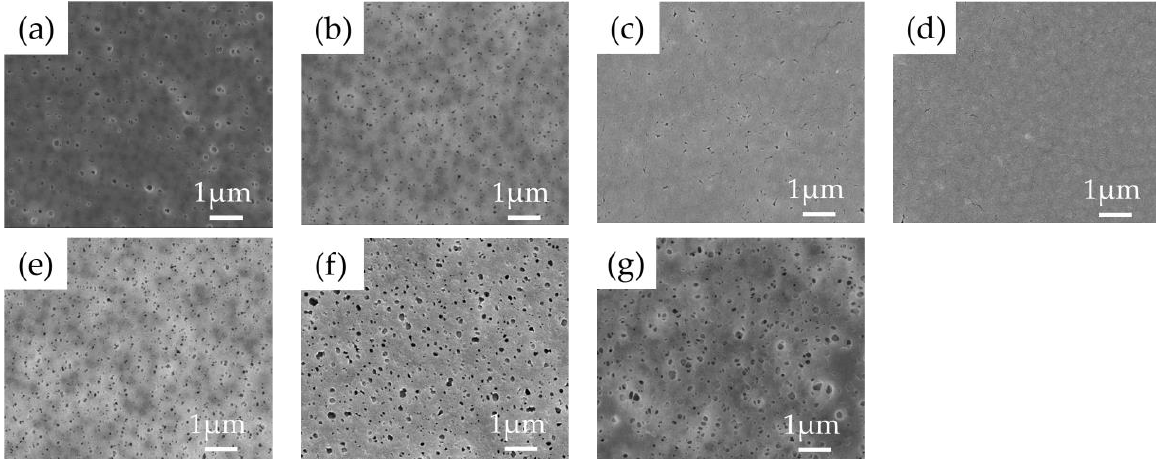
Figure 4. FE-SEM images of top surface of flat-sheet membranes with different PVDF, LiCl concentration and non-solvent compositions: ( a ) (S1) PVDF 14 wt.% with water, ( b ) (S2) PVDF 14 wt.% + LiCl with water, ( c ) (S3) PVDF 16 wt.% + LiCl with water, ( d ) (S4) PVDF 18 wt.% + LiCl with water, ( e ) (S5) PVDF 16 wt.% + LiCl with water (90%) + EtOH (10%), ( f ) (S6) PVDF 16 wt.% + LiCl with water (80%) + EtOH (20%) and ( g ) (S7) PVDF 16 wt.% + LiCl with water (70%) + EtOH